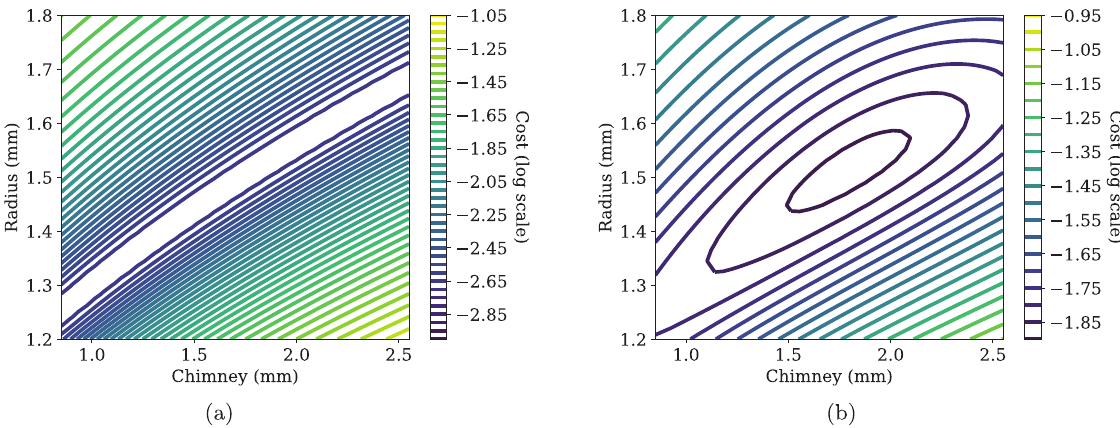
Figure 8. Cost corresponding to the re fl ection coef fi cient, with respect to the fi rst hole radius R h 1 and chimney height H h 1 , for frequencies in [0.1, 4] kHz with a 0.1 kHz step. (a) The fi ngering for which only the fi rst hole is open (oxxx). (b) Five fi ngerings (xxxx, xxxo, xxox, xoxx, oxxx)